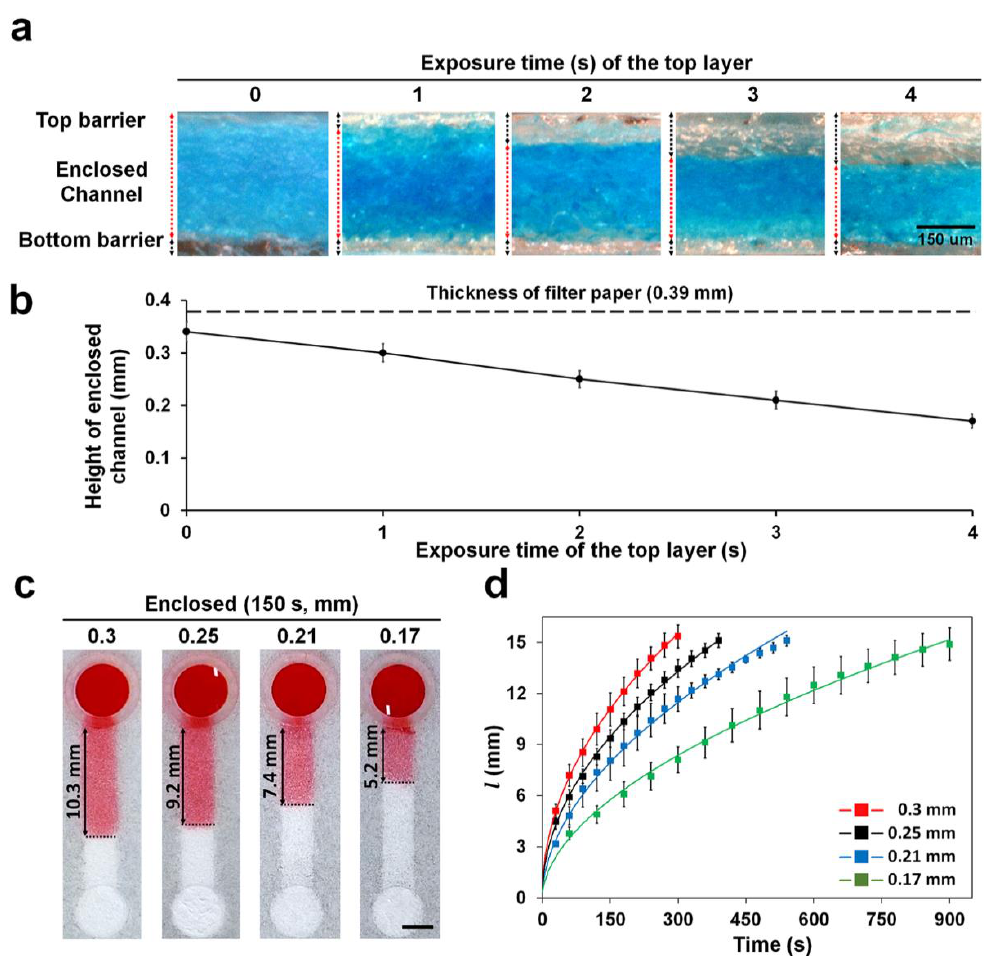
Figure 3. Height of enclosed channels in filter paper at different UV exposure times (0–4 s). ( a ) Cross-sectional views of enclosed channels stained with blue dye flowed from the reservoir. Bare filter paper maintained its hydrophilicity and was stained with the dye. ( b ) Enclosed channels with different heights by varying UV exposure times to print the top barrier in the paper once the bottom and side barriers were printed with UV exposure at 1 and 8 s, respectively. n = 3. ( c ) Image of water wicking along an enclosed channel. The image was taken 150 s after the water dropped on the reservoir. Scale bar: 3 mm. ( d ) l vs. time curve of water wicking along an enclosed channel with height varying from 0.17 to 0.3 mm. Sample volume: 30 μL, n ≥ 3.